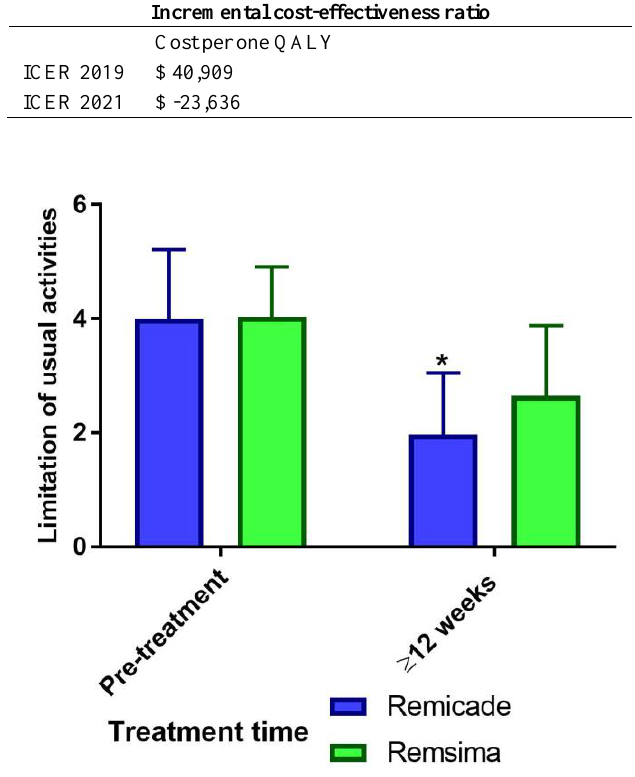
Figure 1 : The difference in the limitation of usual activities (QoL) between the two groups before and ≥12 weeks after infliximab treatment *Significantly (P-value 0.05) lower compared to the level in the Remsima group